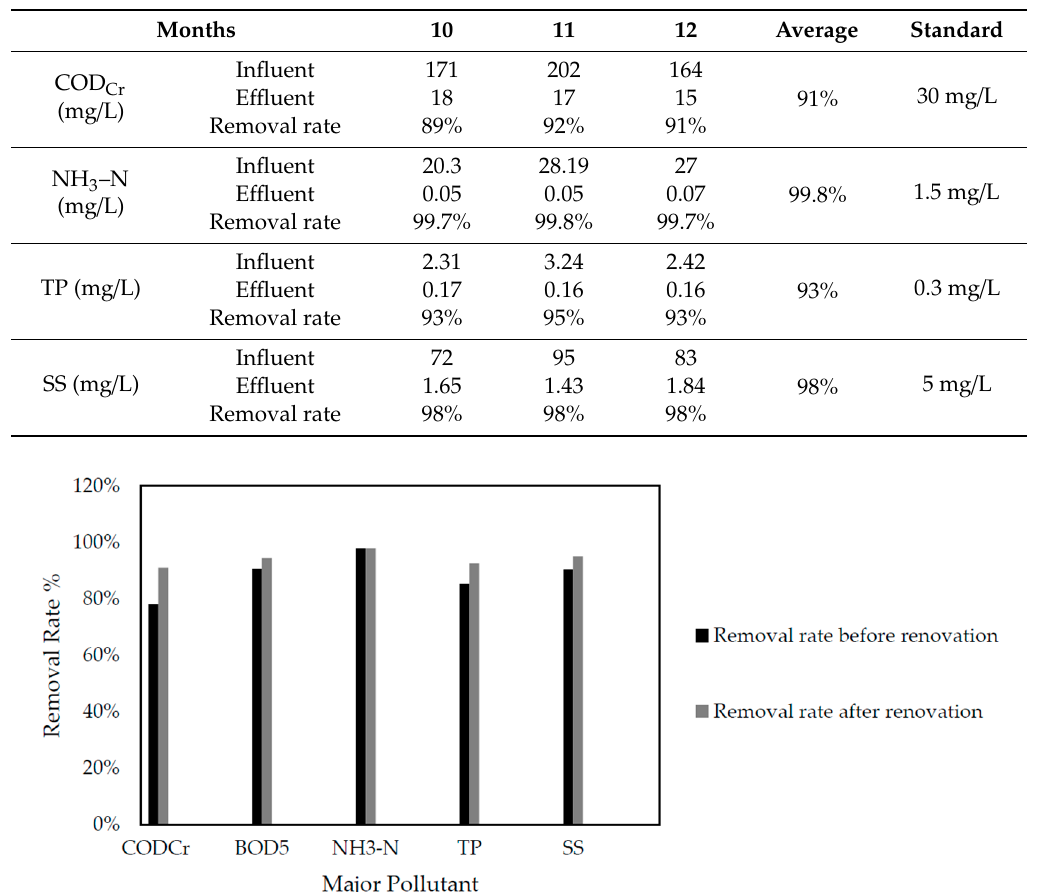
Table 5. Main pollutant indicators of the influent and effluent from the WWTP after renovation.